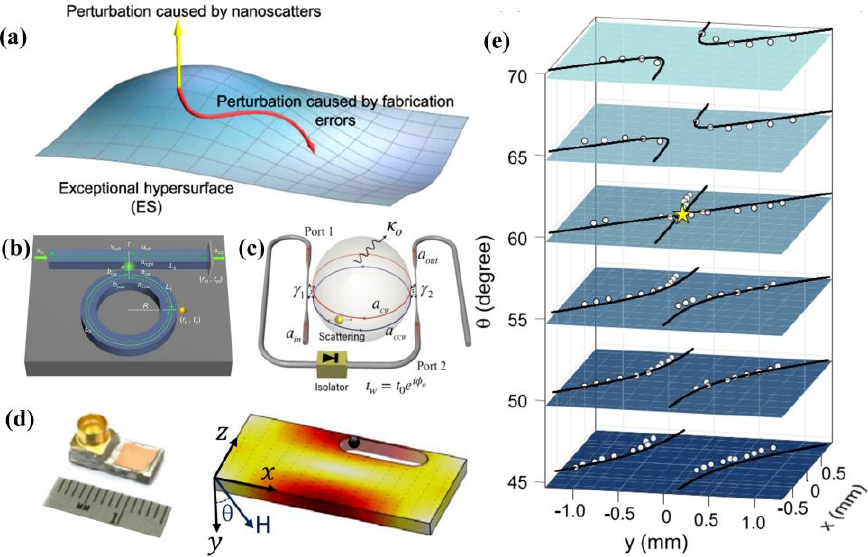
Figure 10. ( a ) The concept map of ES. Adapted with permission from Ref. [148]. Copyright (2019), American Physical Society. ( b ) Schematic diagram of the ES photonic structure. ( c ) Diagram of unidirectional coupling ES structure. Adapted with permission from Ref. [151]. Copyright (2021), Wiley − VCH GmbH. ( d ) Diagram of magnon polariton system. Adapted with permission from Ref. [149]. Copyright (2019), American Physical Society. ( e ) Slices of ES in the 3D parameter space ( x , y , θ ).